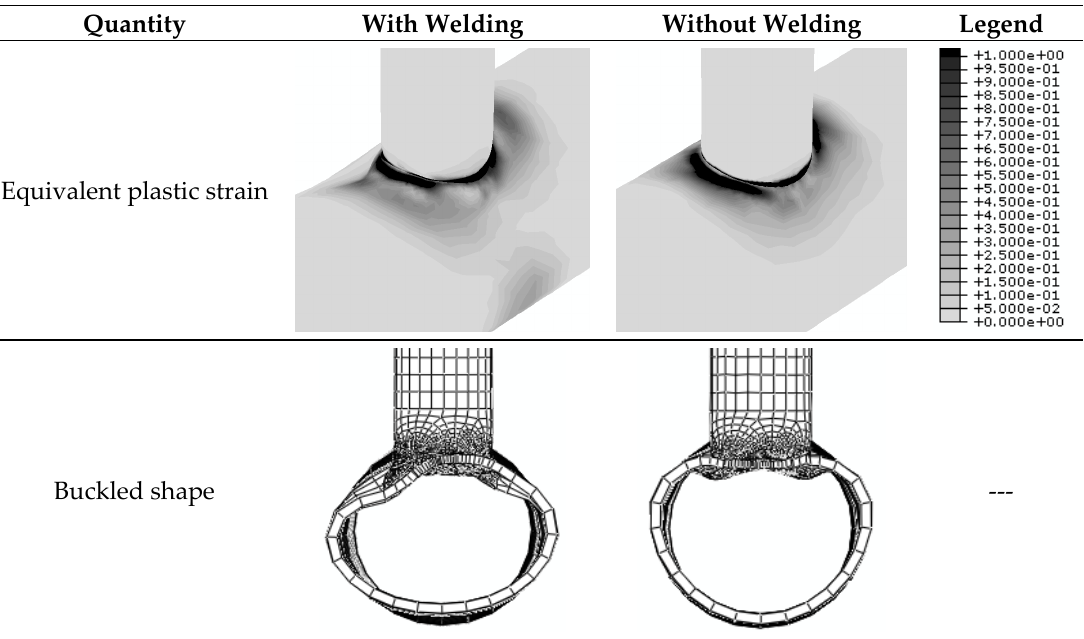
Figure 7. Contours of the equivalent plastic strain and the buckled deformation shape at the end of the axial cyclic loading. The J1 model with and without considering the welding process.